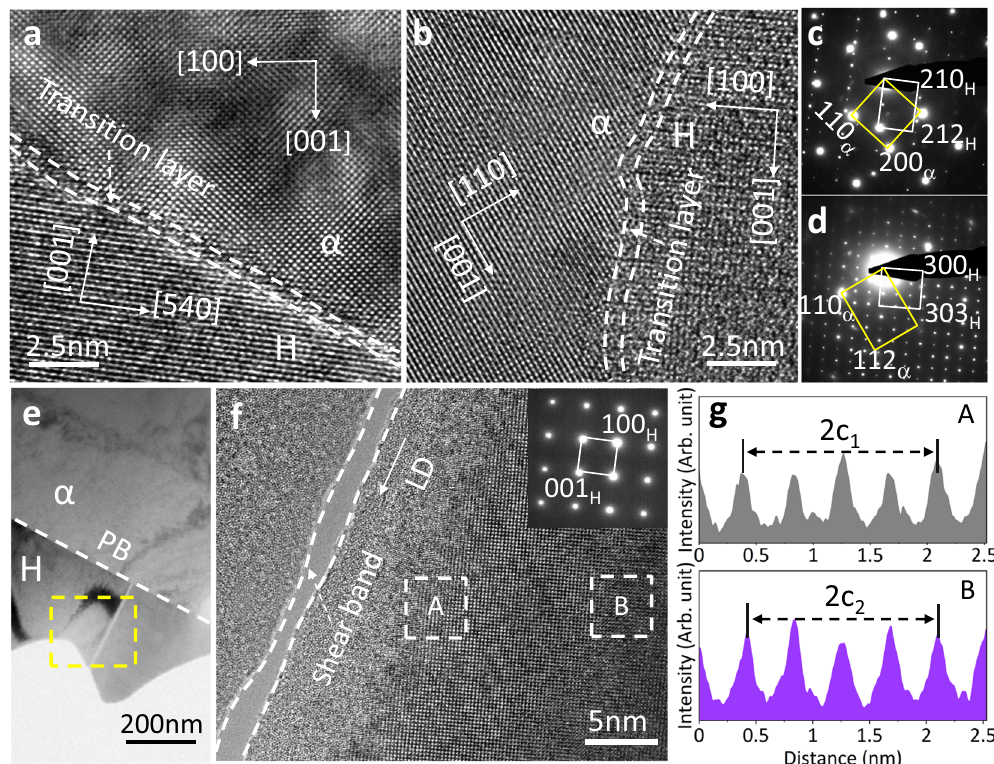
Fig. 5 TEM studies of S-4 alloy. a , b High-resolution transmission electron microscopy (HRTEM) image at the phase interface, oriented to the [001] α zone axis ( a ) and [110] α zone axis ( b ), respectively. c , d Selected area electron diffraction (SAED) at the phase interface correspond to Fig. 5a and b, respectively. e The microstructure of the S-4 alloy at the strain of − 5% along the loading direction, the white dashed line indicates the phase boundary (PB). f The HRTEM image at the shear band area of the H phase, insert is the SAED at the H phase, oriented to the [010] zone axis. The local shear band is formed after large compressive deformation. g Intensity pro fi le along with LD in A and B zones marked in Fig.